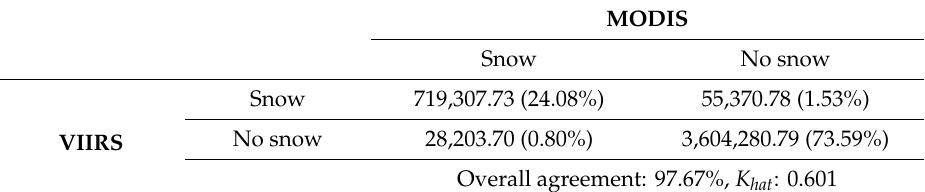
Table 3. Confusion matrix between MYD10L2 and VSCMO during the 2016 hydrological year . ( Note: MYD10L2 is Aqua MODIS swath snow map product and VSCMO is NOAA VIIRS binary